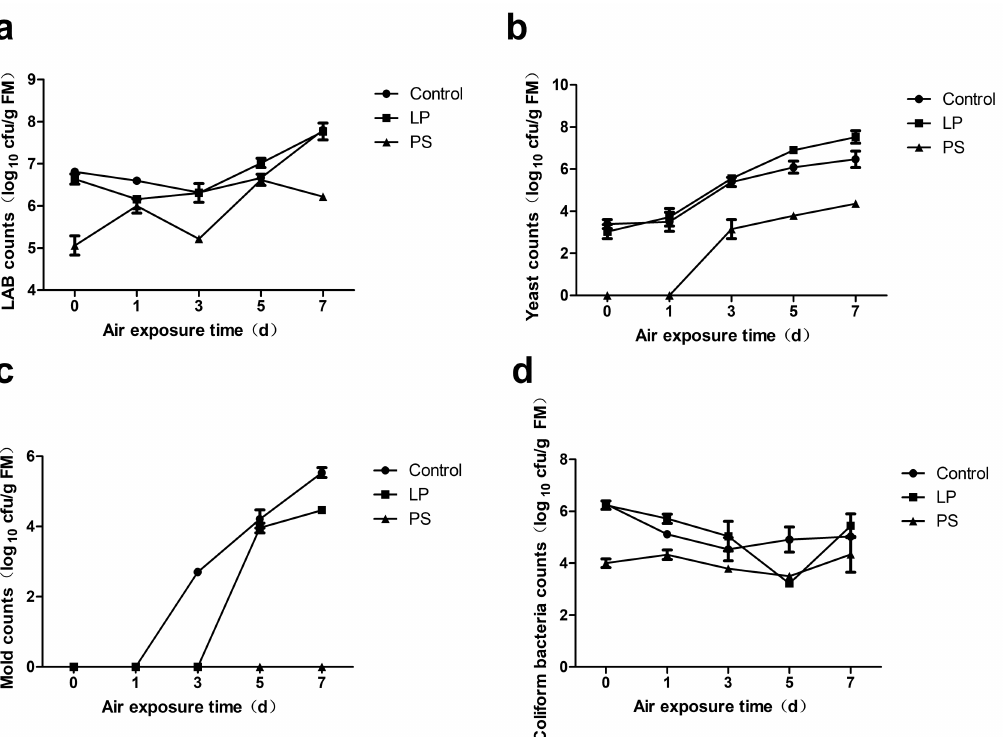
Figure 3. Dynamic changes in lactic acid bacteria (LAB) counts ( a ), yeast counts ( b ), mold counts ( c ), and coliform bacteria counts ( d ) of TMR silages during the processing of aerobic deterioration (bars indicate standard error of the means). cfu, colony-forming units; FM, fresh matter; LP, Lactobacillus plantarum inoculant; PS, potassium